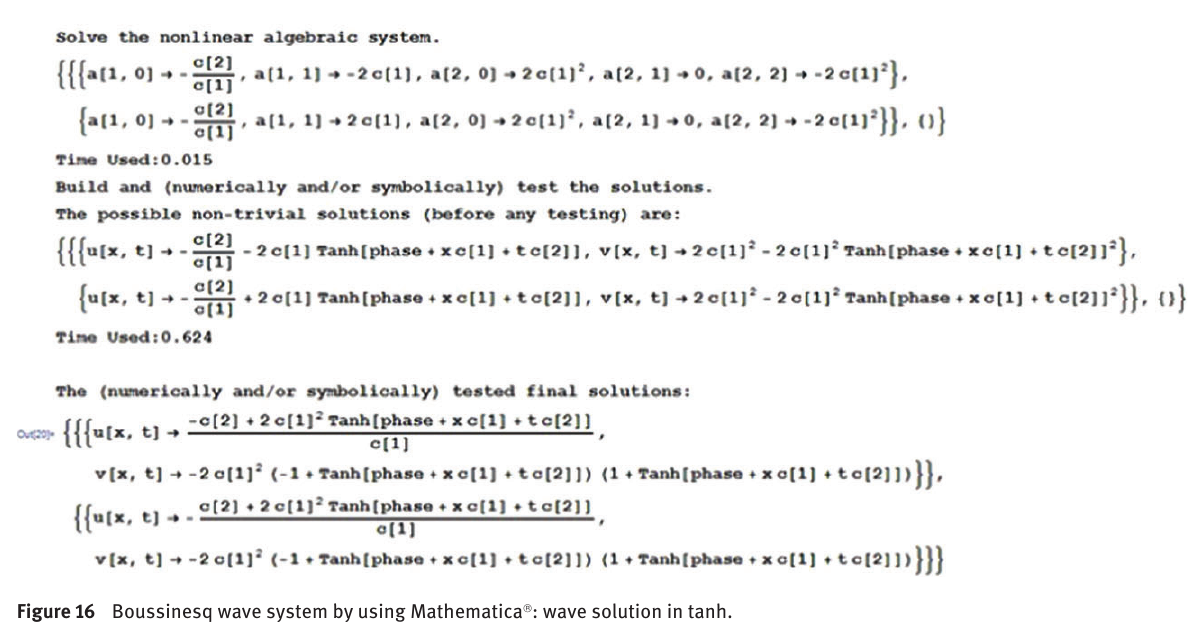
Figure 16 Boussinesq wave system by using Mathematica ® : wave solution in tanh.